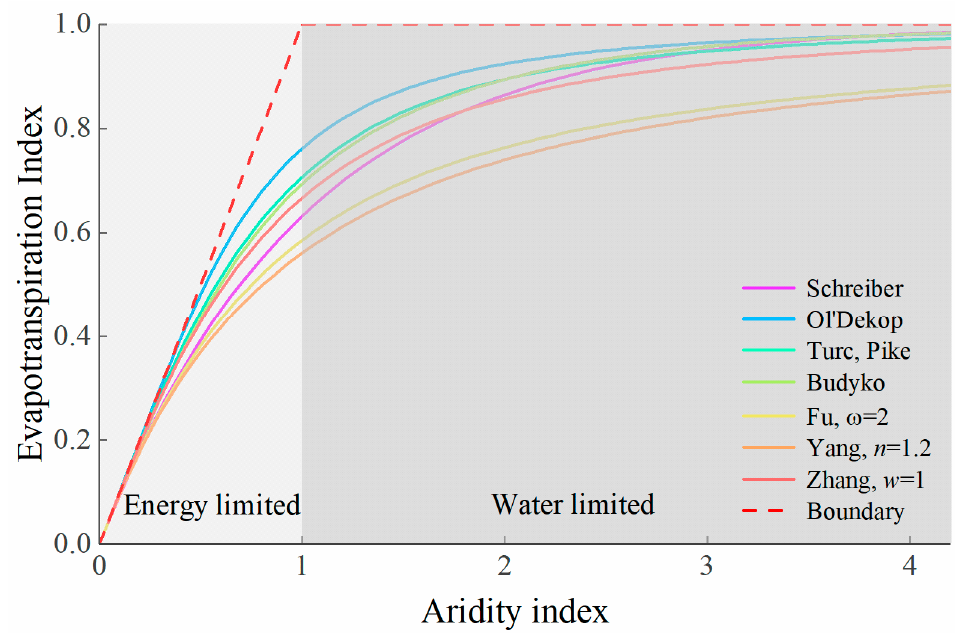
Figure 2. Boundary conditions of the Budyko framework and different Budyko-type functions. The red dotted lines represent the boundary conditions of the Budyko framework, and the colored lines are different Budyko-type functions.